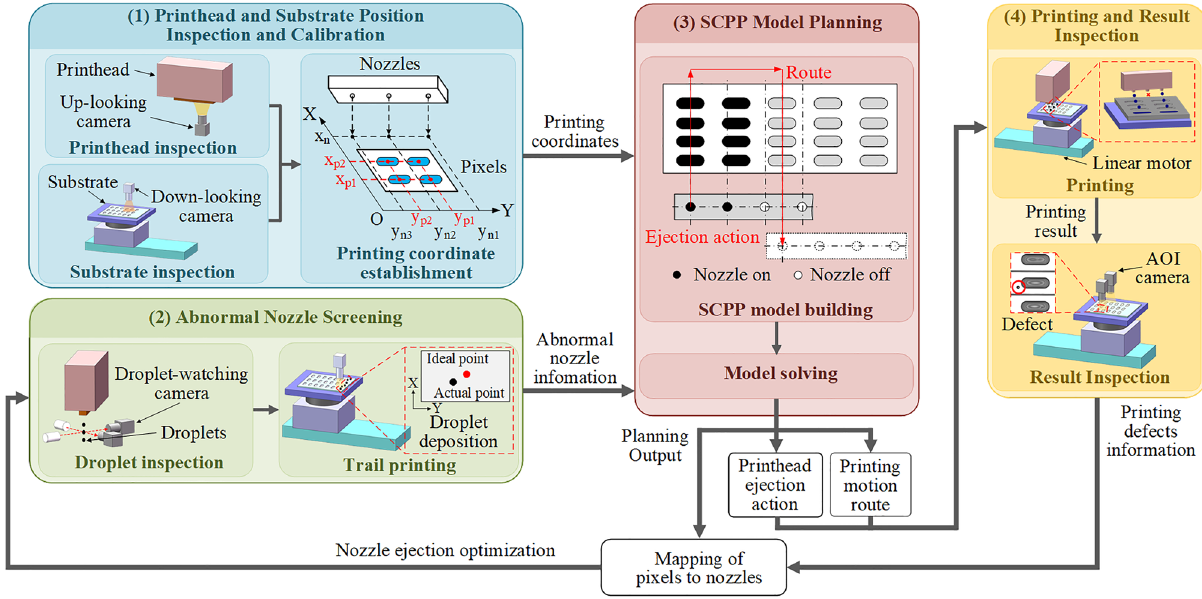
Figure 3. Schematic diagram of the principles of the display pixel inkjet printing